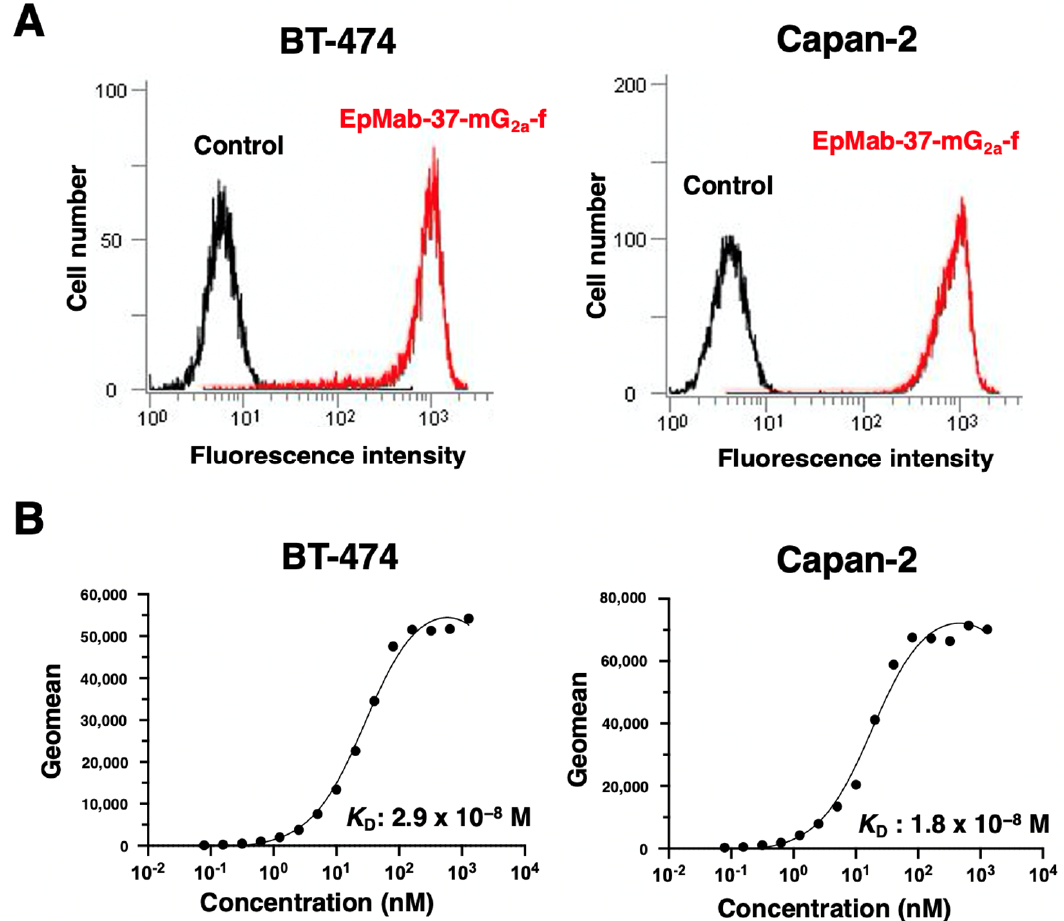
Figure 1. Flow cytometric analyses. ( A ) BT-474 and Capan-2 cells were treated with 10 μg/mL of EpMab-37-mG 2a -f (red line) or blocking buffer as a negative control (black line), followed by addi- tion of Alexa Fluor 488-conjugated anti-mouse IgG. Data were collected using the EC800 Cell Ana- lyzer. ( B ) BT-474 and Capan-2 cells were suspended in 100 μL of serially diluted EpMab-37-mG 2a -f (0.006–100 μg/mL), followed by the addition of Alexa Fluor 488-conjugated anti-mouse IgG. Data were collected using the BD FACS Lyric and analyzed by GraphPad PRISM 9 to determine the ap- parent dissociation constant ( K D ) .